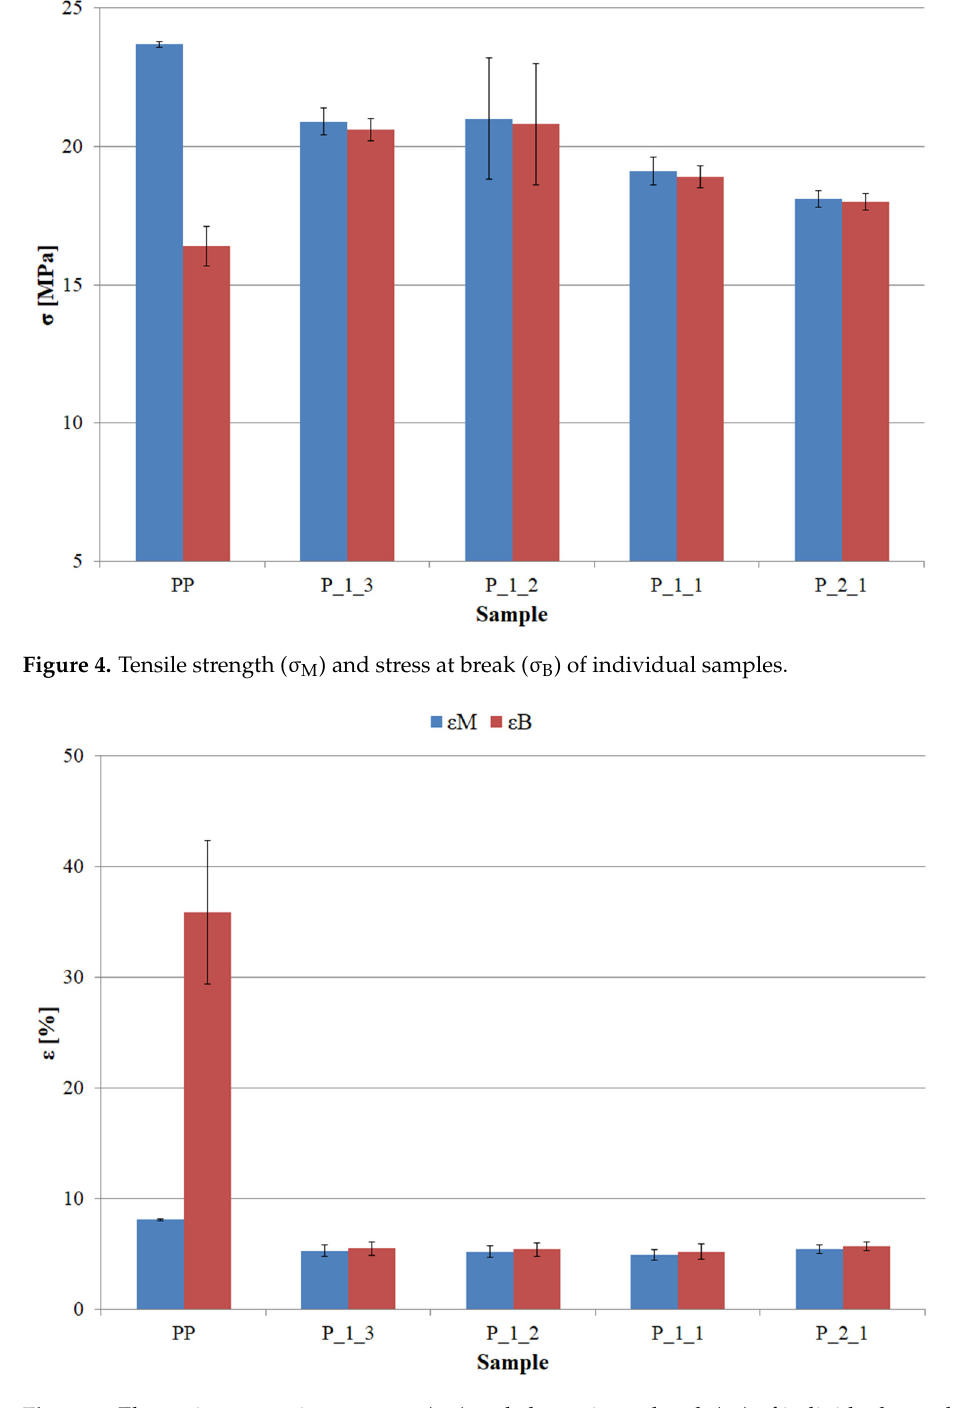
Figure 6. The impact strength (u a ) of individual samples.